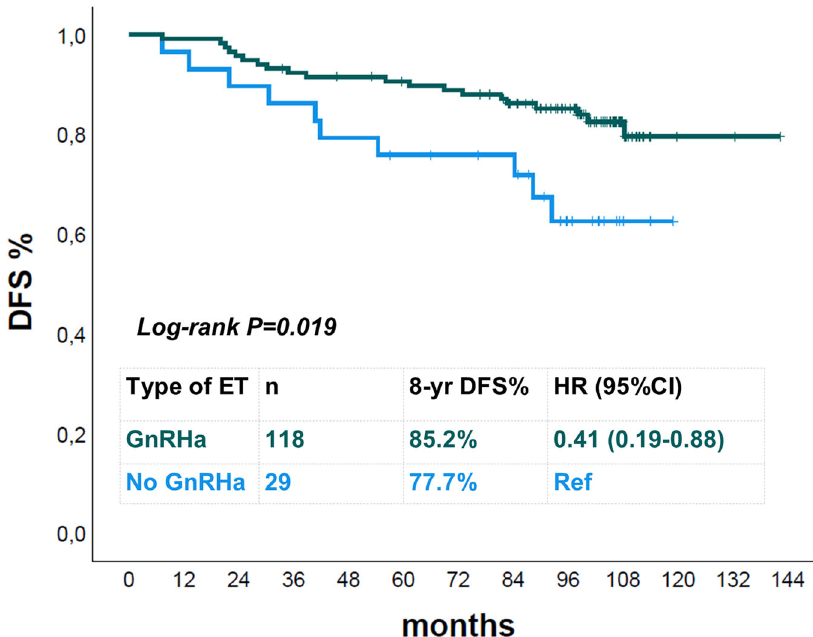
Fig. 3 DFS Kaplan – Meier curves according to GnRHa use in premenopausal patients aged ≤ 45